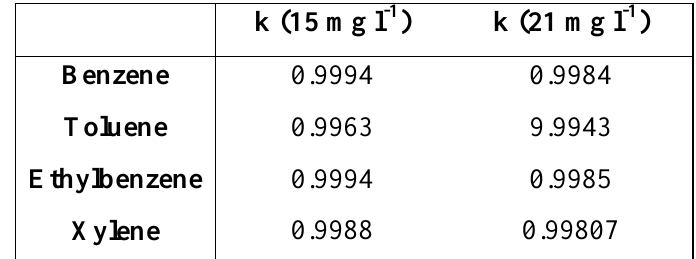
Table 1. Reversibility of polystyrene-coated QCN toward